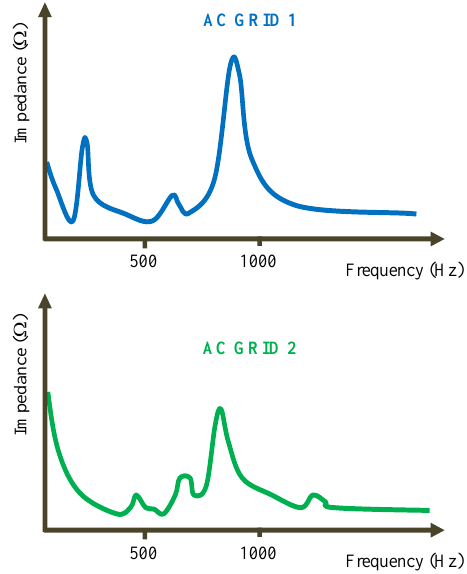
Figure 2. Possible equivalent impedance of AC grids seen at one specific point, due to the combination of several elements connected to the given grids (for example, a strong presence of subterranean or submarine cables such as those in wind parks, transformer, shunt compensators, and harmonic passive filters)